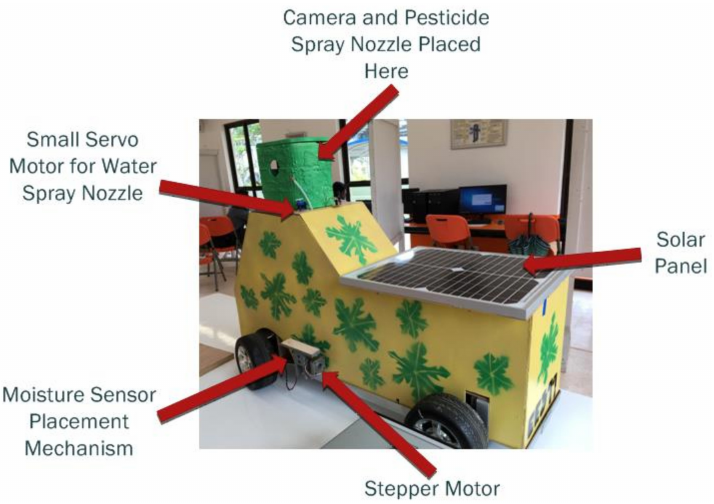
Figure 6. The prototype of the developed multi-purpose smart farming robot.